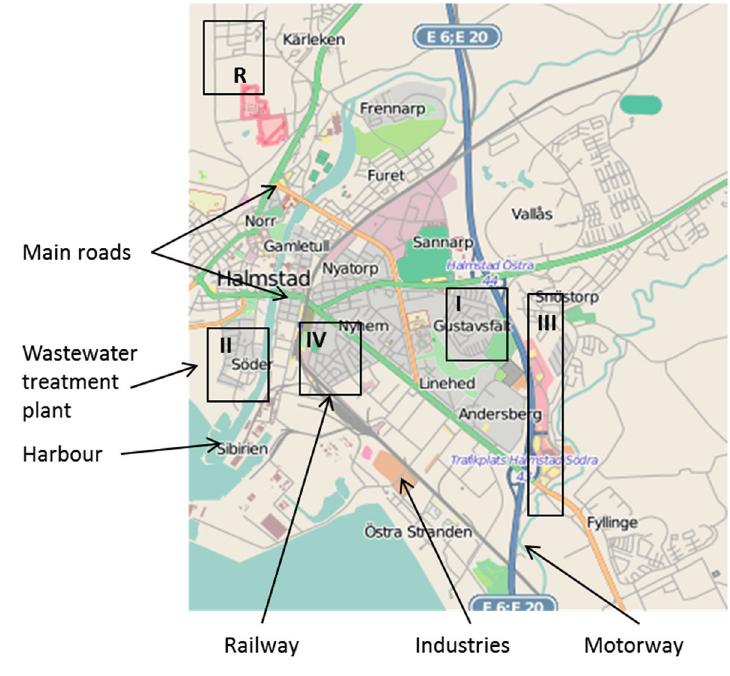
Figure 1. Map of Halmstad showing the five investigated areas and potential stressor